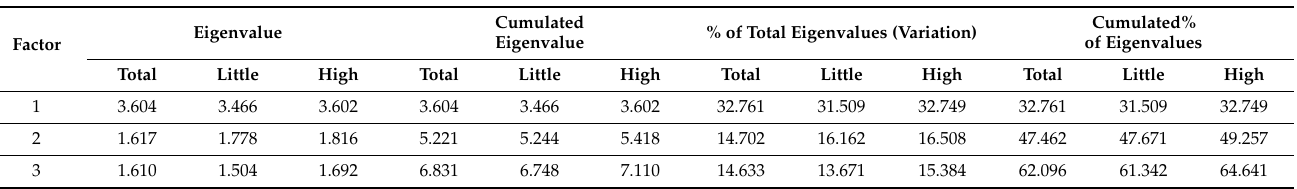
Table 6. Hierarchy of factors according to their eigenvalues determined on the basis of the Kaiser criterion (for the total respondents and according to the self-assessment of the level of knowledge about green